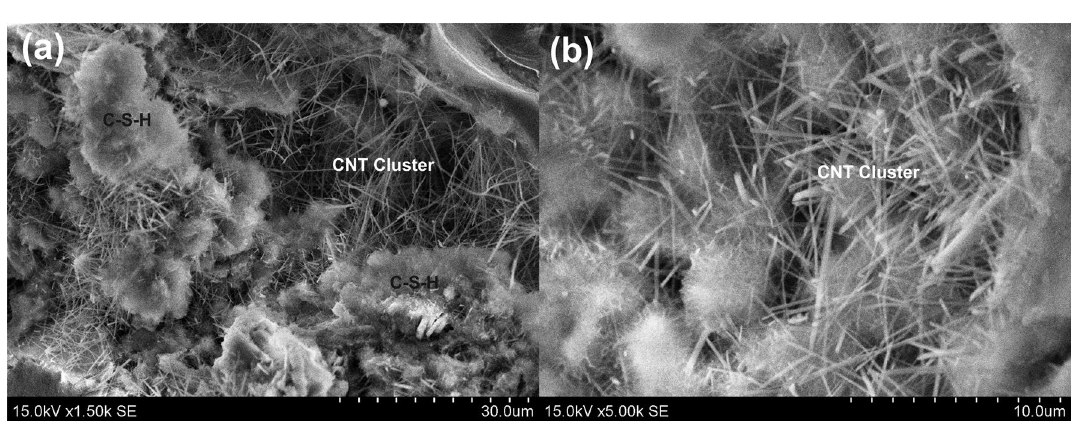
Figure 8. The well-dispersed concrete sample under high concentration of CNT at different magnification; the presence of C–S–H gel surrounding to the